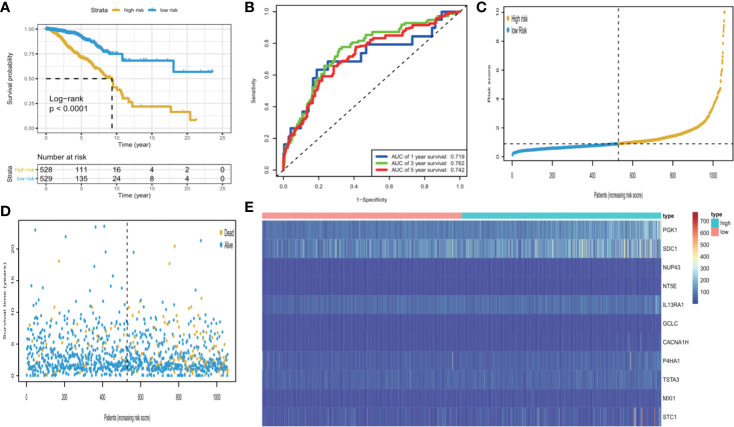
KM survival analysis, risk score assessment by the GRG‐related gene signature and time-dependent ROC curves in the TCGA cohort. (A) KM survival analysis of high‐ and low‐risk samples. (B) ROC curve for overall survival of the training set. The AUC was assessed at 1, 3, and 5 years. (C) Risk score distribution, (D), survival status, and (E). Eleven GRGs expression patterns for patients in high- and low-risk groups by the 11-GRG signature.